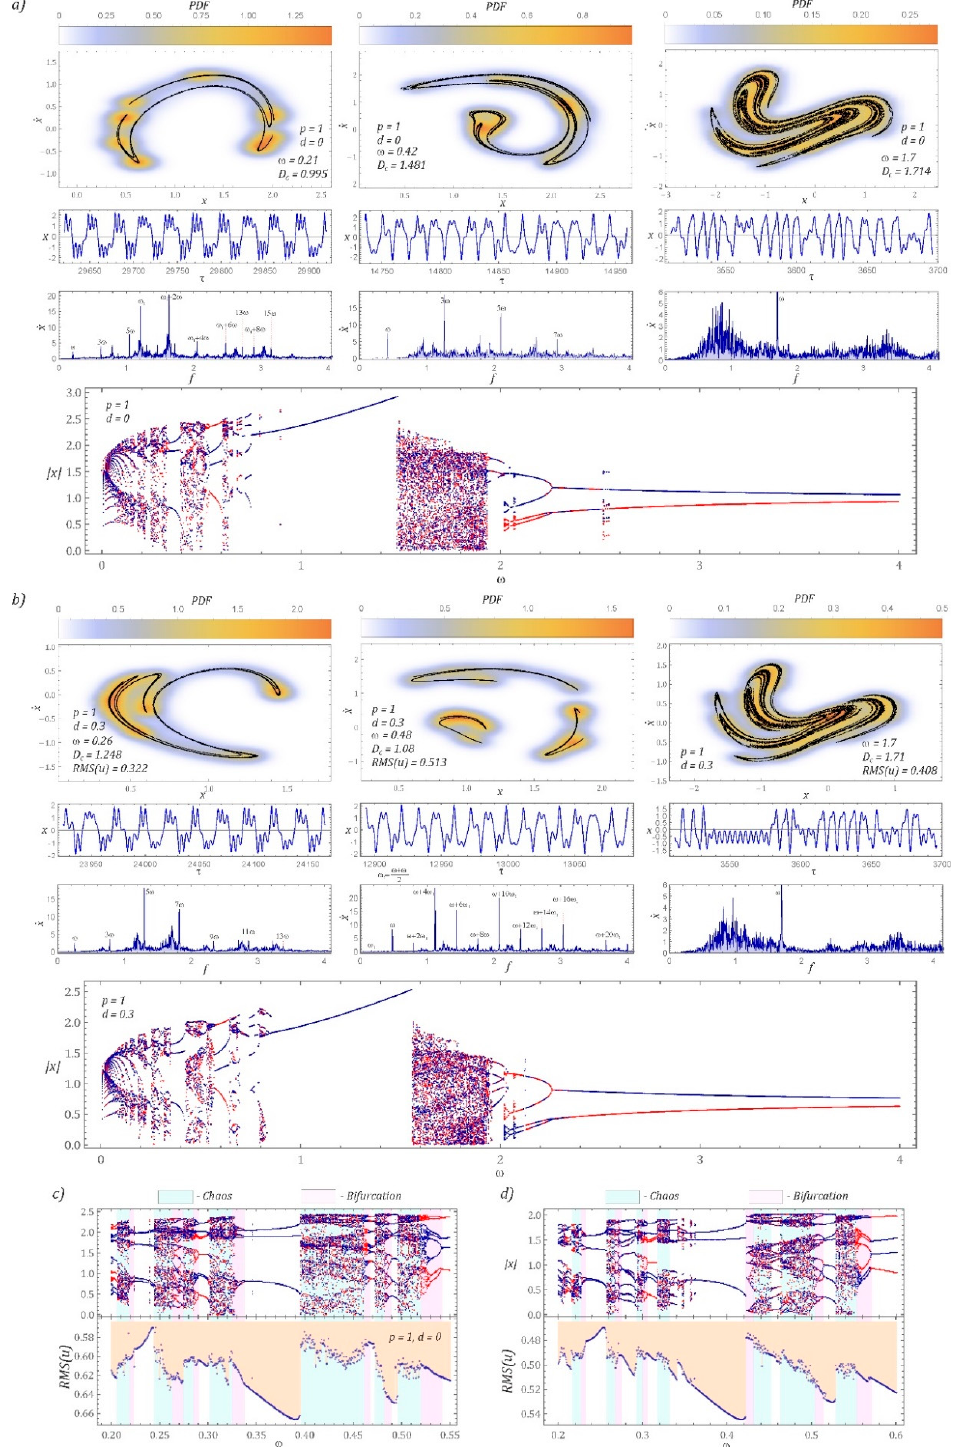
Figure 3. Influence of the parameter d on the geometric structure of the Poincaré cross-section: ( a ) d = 0, ( b ) d = 0.3. Starting from the top, the horizontal panels correspond to the Poincaré map and the corresponding time series for selected ω and amplitude–frequency spectrum. The bottom panels show the bifurcation diagrams based on the local minima (red) and the local maxima (blue) compared with RMS(u) for d = 0.3. To clarify the influence of the parameter d on bifurcations in the selected frequency interval, ( c , d ) magnify the difference between the cases d = 0 and d = 0.3, respectively. The simulation results were obtained assuming zero initial